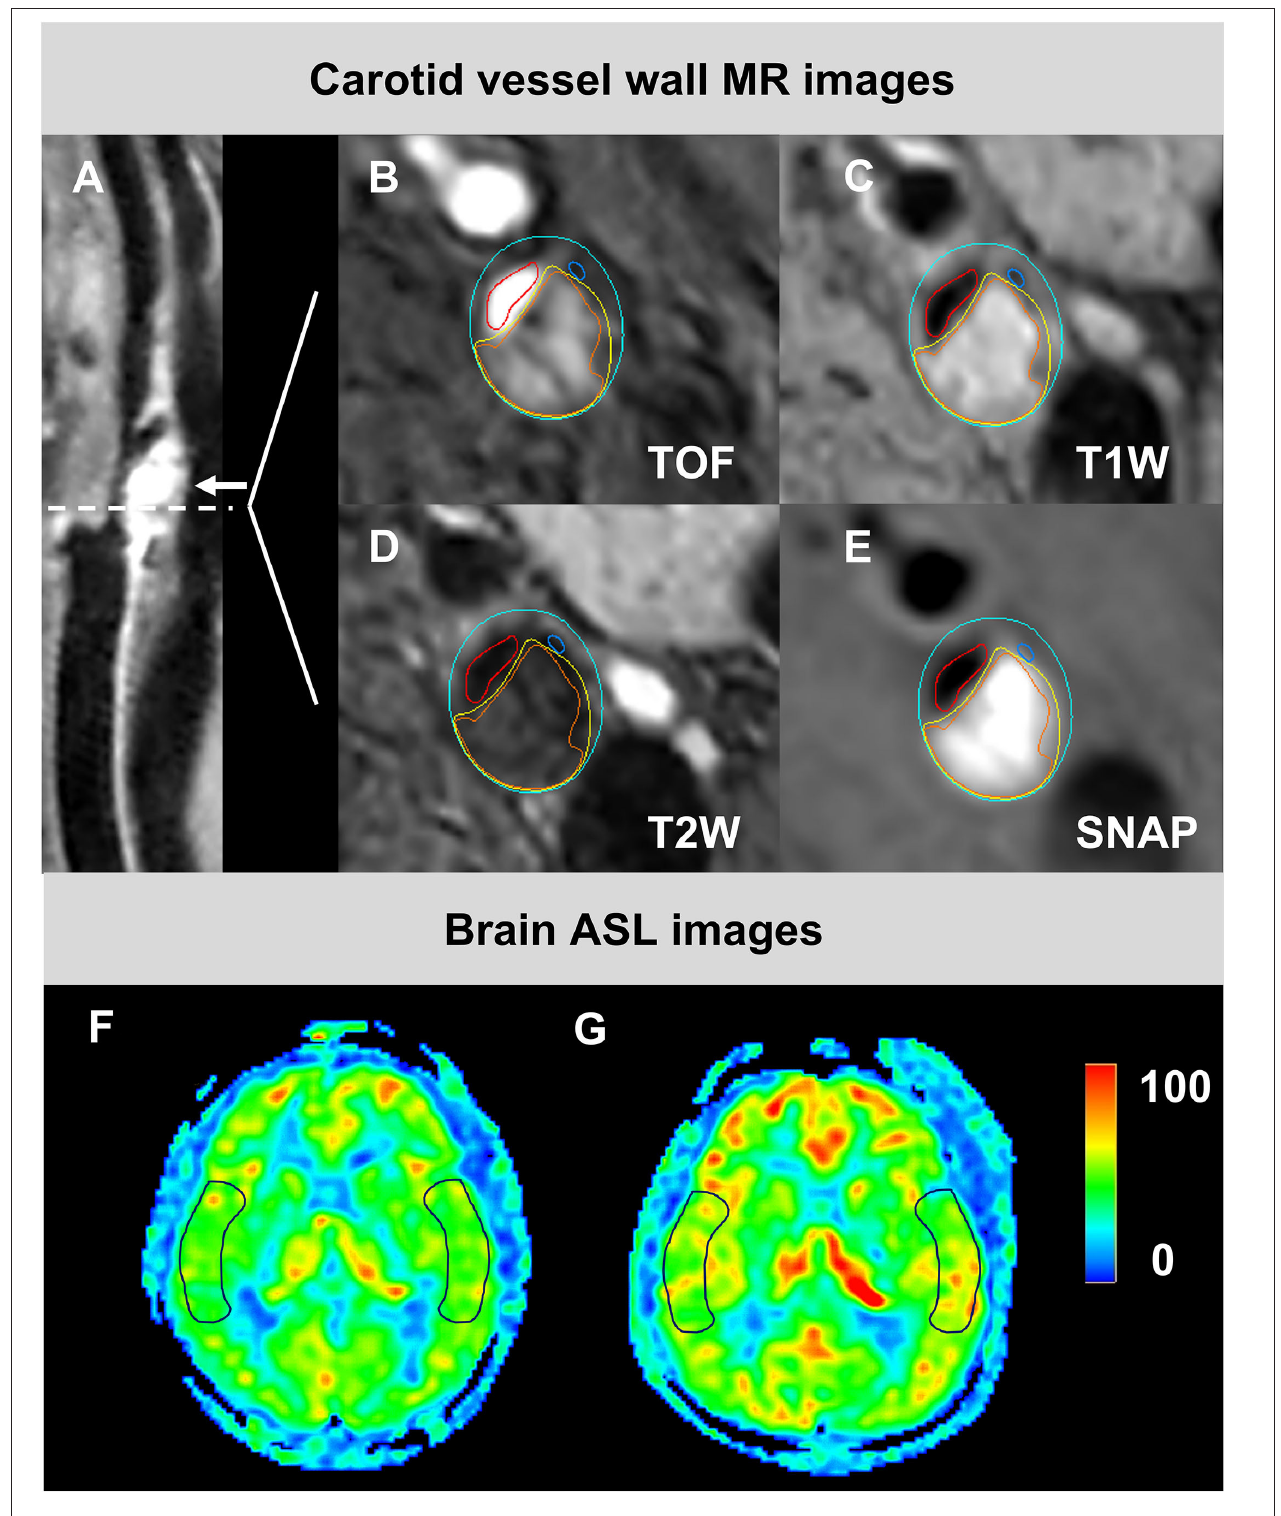
FIGURE 1 | The images from a 85-year-old male patient who had carotid atherosclerotic plaque with IPH and calcification in the left side and changed CBF undergoing CEA. An eccentric plaque (white arrow) was delineated in the curved projection reconstructed image of 3D T1W (A) . IPH (orange), calcification (navy